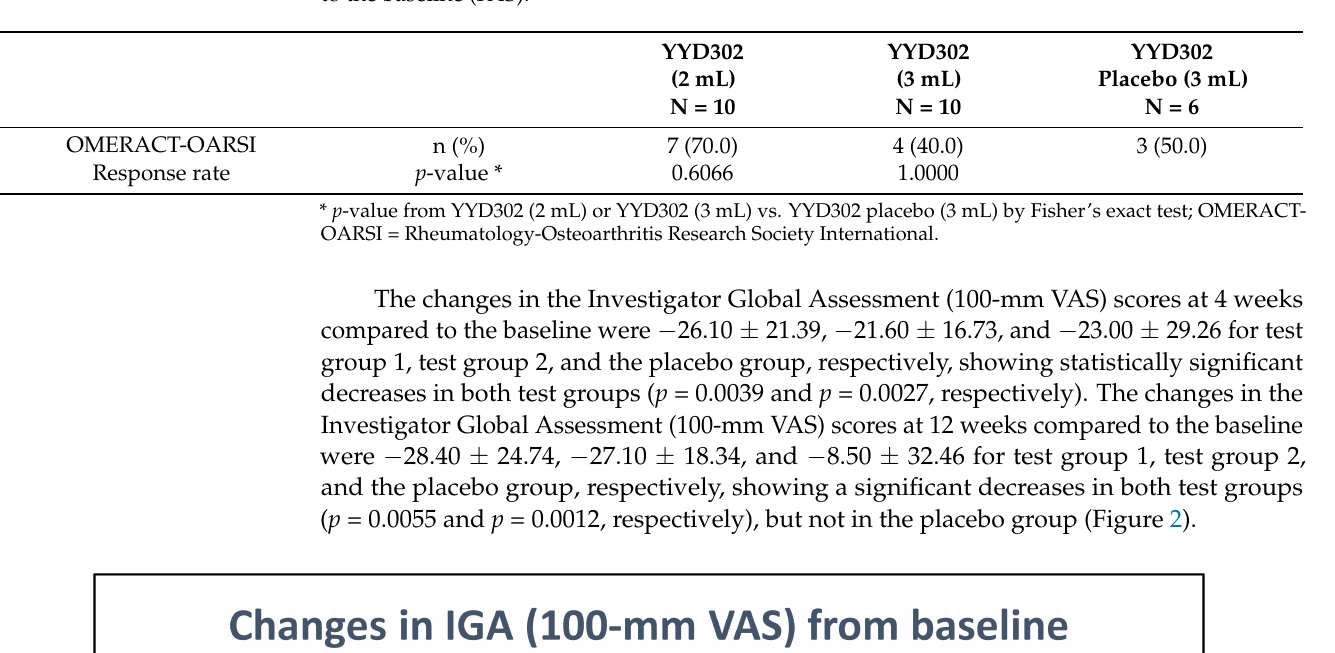
Table 4. Changes in the OMERACT-OARSI response rate at 12 weeks after administration, compared to the baseline (FAS).